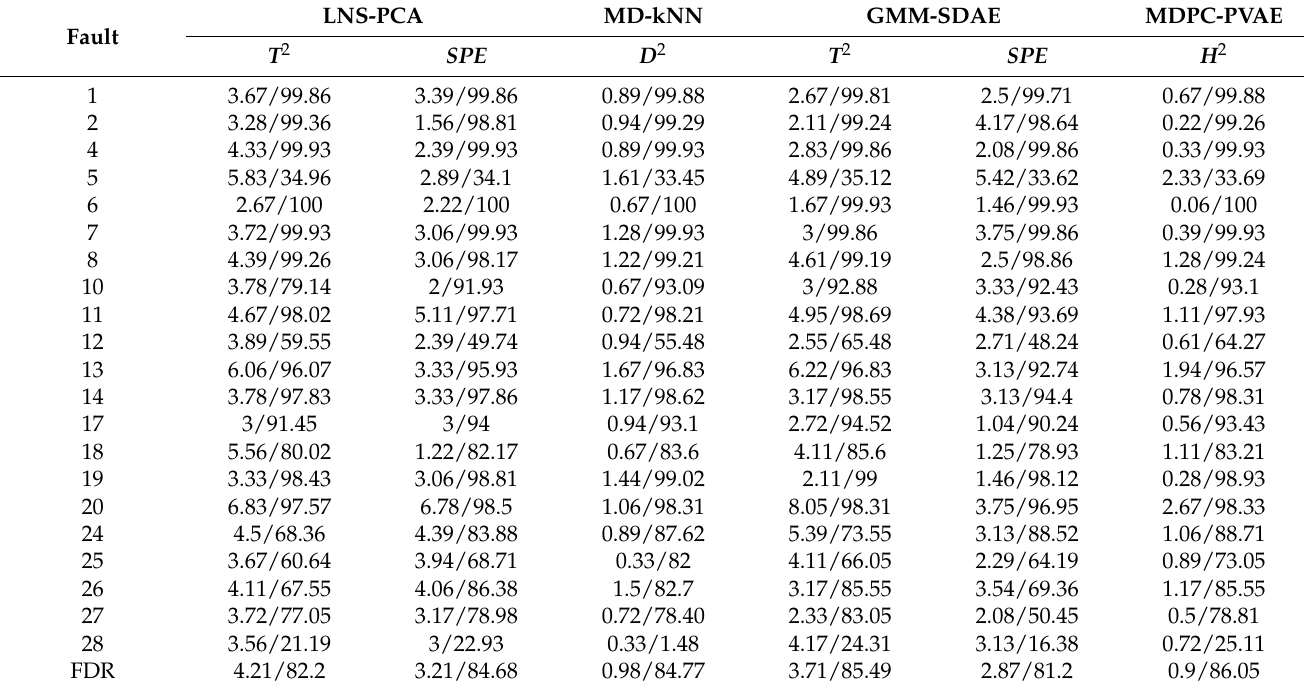
Table 2. FAR/FDR of MDPC-PVAE and the other methods on the TE